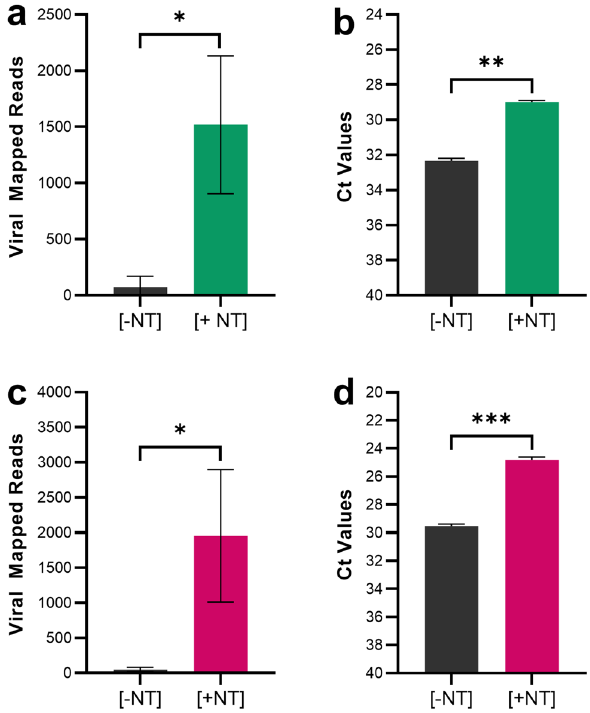
Figure 6. Magnetic Hydrogel Particles (Nanotrap Particles) Improve Sequencing of Multiple Respiratory Viruses. Heat-inactivated influenza A (H1N1) ( a , b ) or RSV ( c, d ) was spiked into VTM at 10 6 TCID 50 /mL